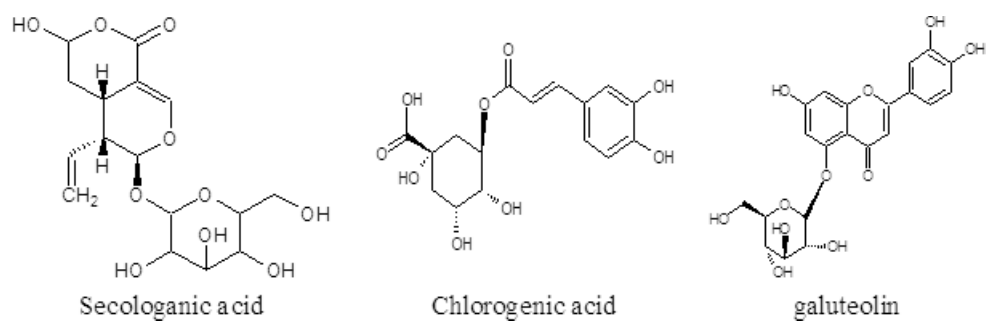
Fig. 1. Chemical structures of the investigated analytes.